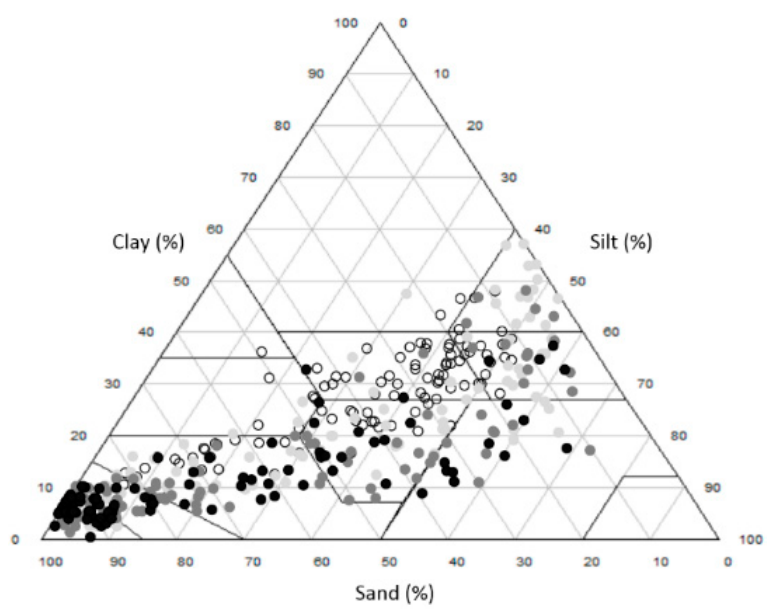
Figure 3. The textural distribution of soil samples from four different depths between 0 to 1 meter, where the darker colors correspond to the deepest depths. The samples were collected from a 73-ha two-pivot irrigation field that is located in southwestern Dyer County, Tennessee.